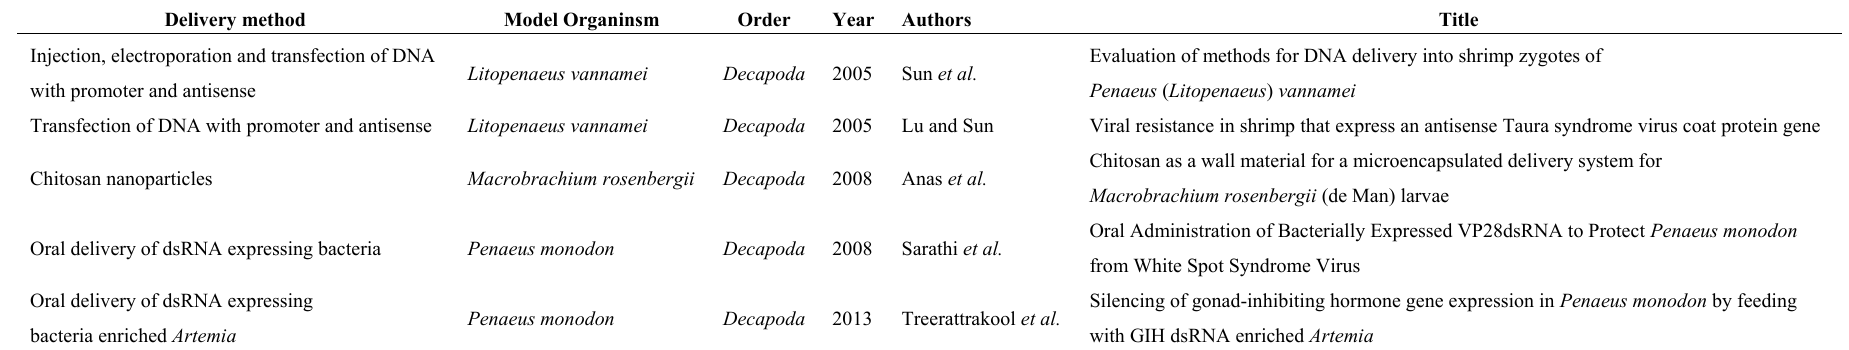
Table 2. Summary of RNAi administration methods in crustaceans.